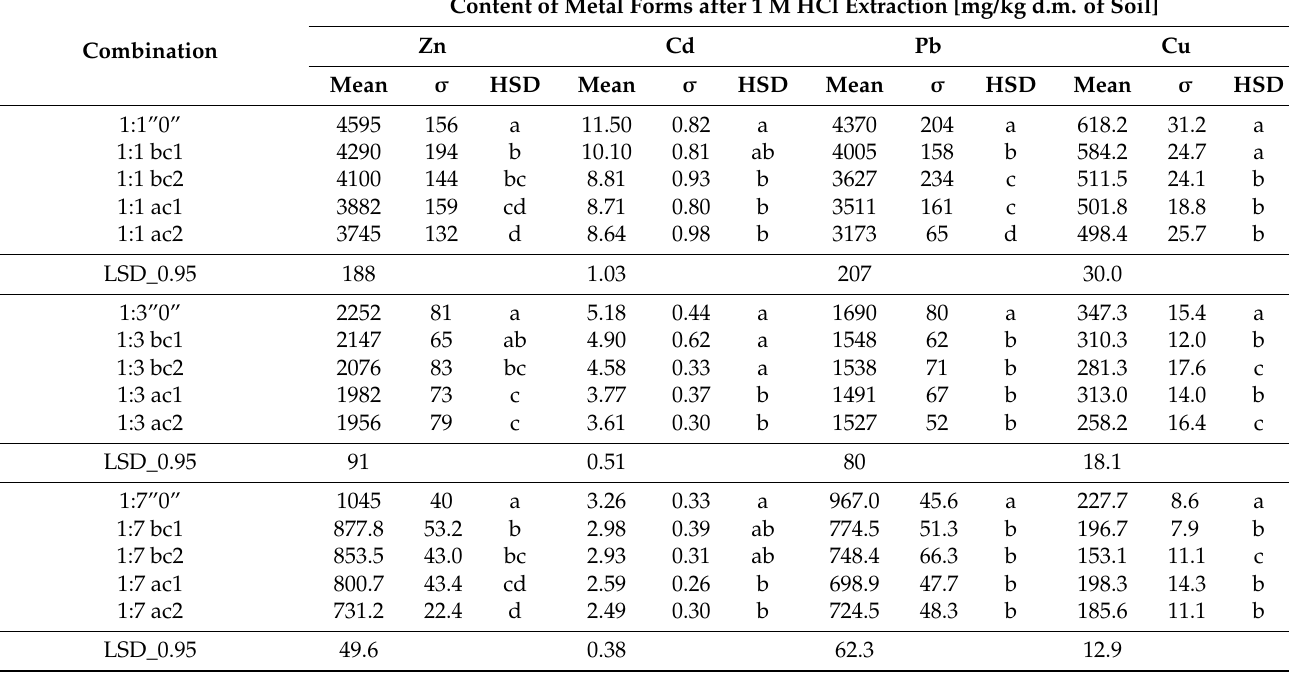
Table 4. Content of metal forms after 1 M HCl extraction, depending on the dose of brown coal and activated carbon.